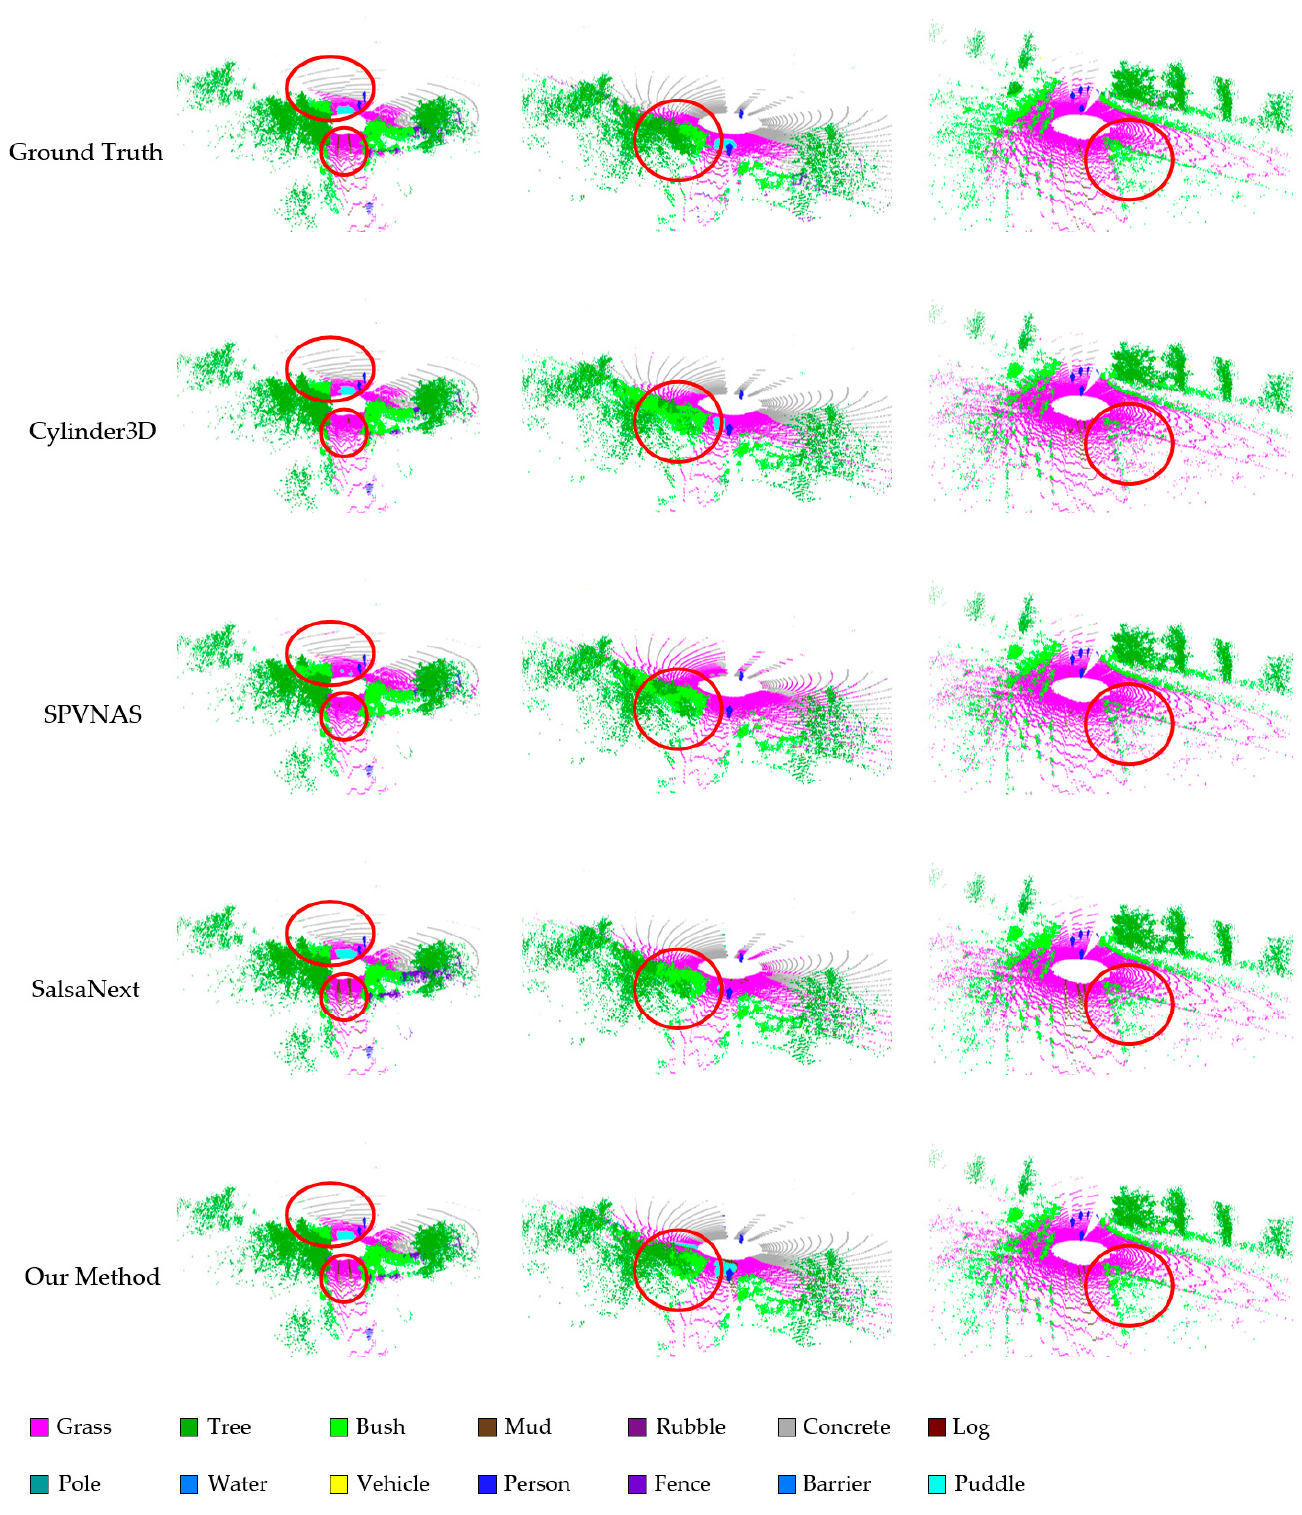
Figure 7. Visual comparison with different state-of-the-art methods on RELLIS-3D dataset.